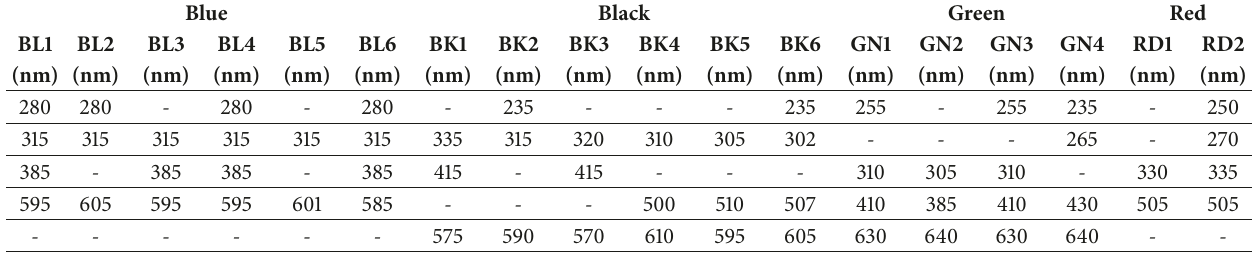
Table 2: Different absorption bands for blue, black, green and red fountain pen inks using UV/Visible spectroscopy.